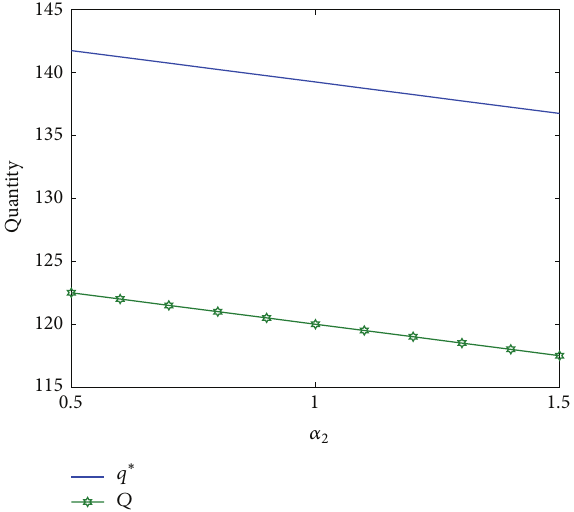
Figure 9: Impact of 𝜎 on ordering quantity under demand certainty and uncertainty.